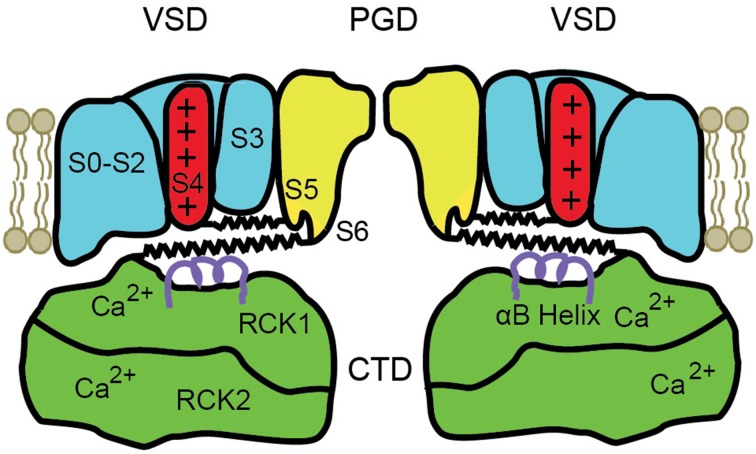
Schematic of the modular structure of a BK channel. The central pore-gate domain (PGD) formed from S5 to S6 of each of the four subunits forms the gates and conducting pore of the channel. Two of the four voltage sensor domains (VSD) that surround the central PGD are shown. The cytosolic domain (CTD) forms a large intracellular gating ring comprised of four RCK1 domains and four RCK2 domains, of which only two of each are shown. Each RCK1 domain contains a high affinity RCK1 Ca2+ binding site and each RCK2 domain contains a high affinity Ca2+ bowl binding site. Four S4–S5 linkers connect S4 in the VSDs to the PGD (upper springs) and four RCK1-S6 linkers connect the gating ring to the PGD (lower springs), shown for two subunits. Ca2+ binding expands the gating ring to pull on the RCK1-S6 linkers and can also elevate the αB helices (purple helices) under the VSDs (Yuan et al., 2012). See text for references and detailed explanations.